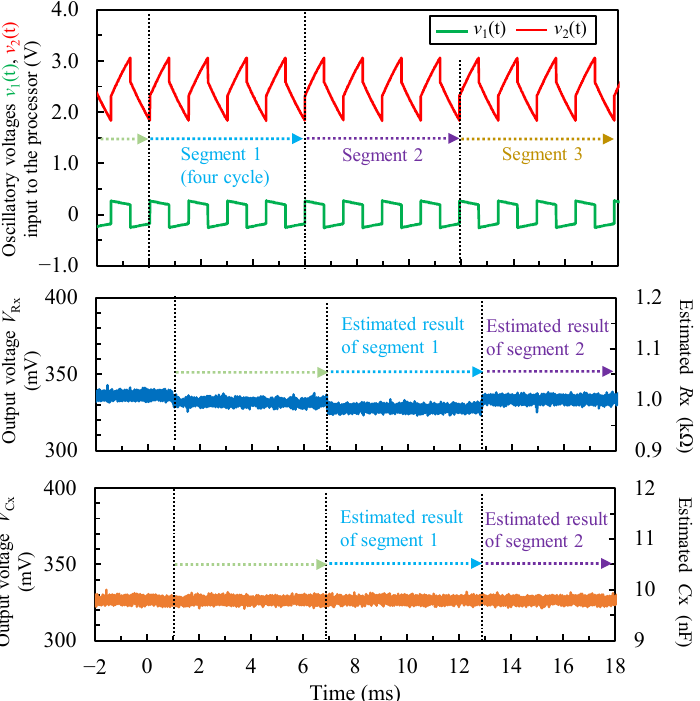
Figure 7. An example of oscillatory voltage v 1 ( t ) and v 2 ( t ) being inputted into the processor, resulting in output voltages of V Rx and V Cx from the proposed FPGA-based processor when R x = 1.0 k Ω , C x = 10 nF, M was set as 19th order, R max was set at 10 k Ω , and C max was set at 100 nF. The top plot is the output of the nonsinusoidal oscillator circuit when connected to the measurement object through capacitive coupling and the input waveform of the proposed processor. v 1 ( t ) and v 2 ( t ) have nothing else to convert. The bottom two plots show the results of the R x and C x circuit parameters estimated and converted into voltages for each segment (four cycles). These voltages were converted back into estimated values R x and C x , and are shown on the right side of the y-axis as the estimated values corresponding to the voltage.